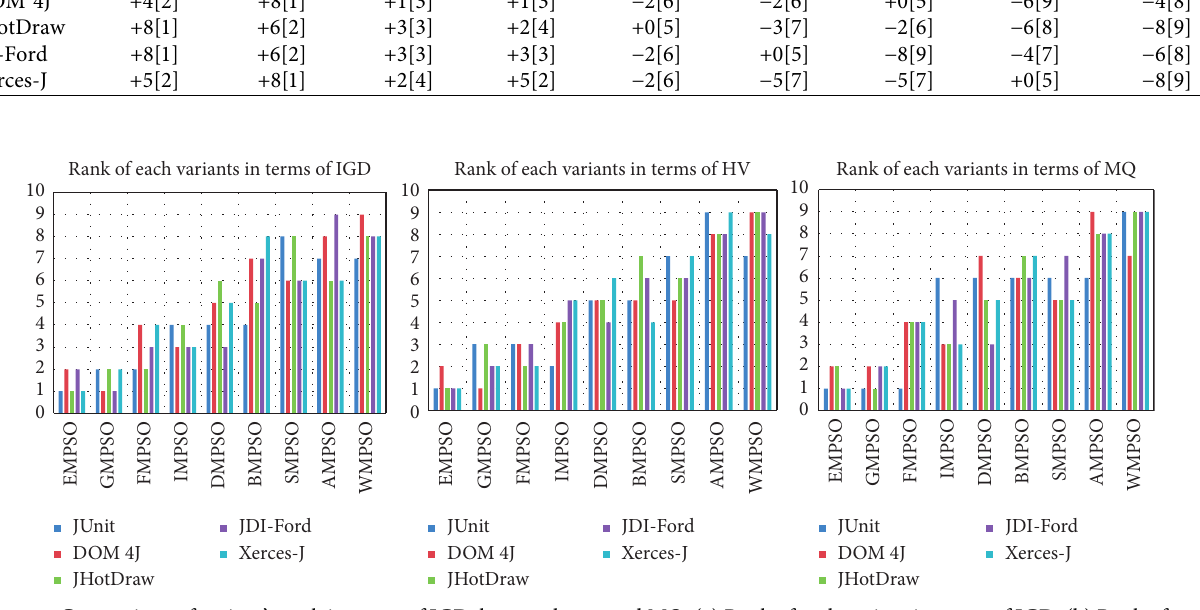
Figure 5: Comparison of variant’s rank in terms of IGD, hypervolume, and MQ. (a) Rank of each variant in terms of IGD. (b) Rank of each variant in terms of HV. (c) Rank of each variant in terms of